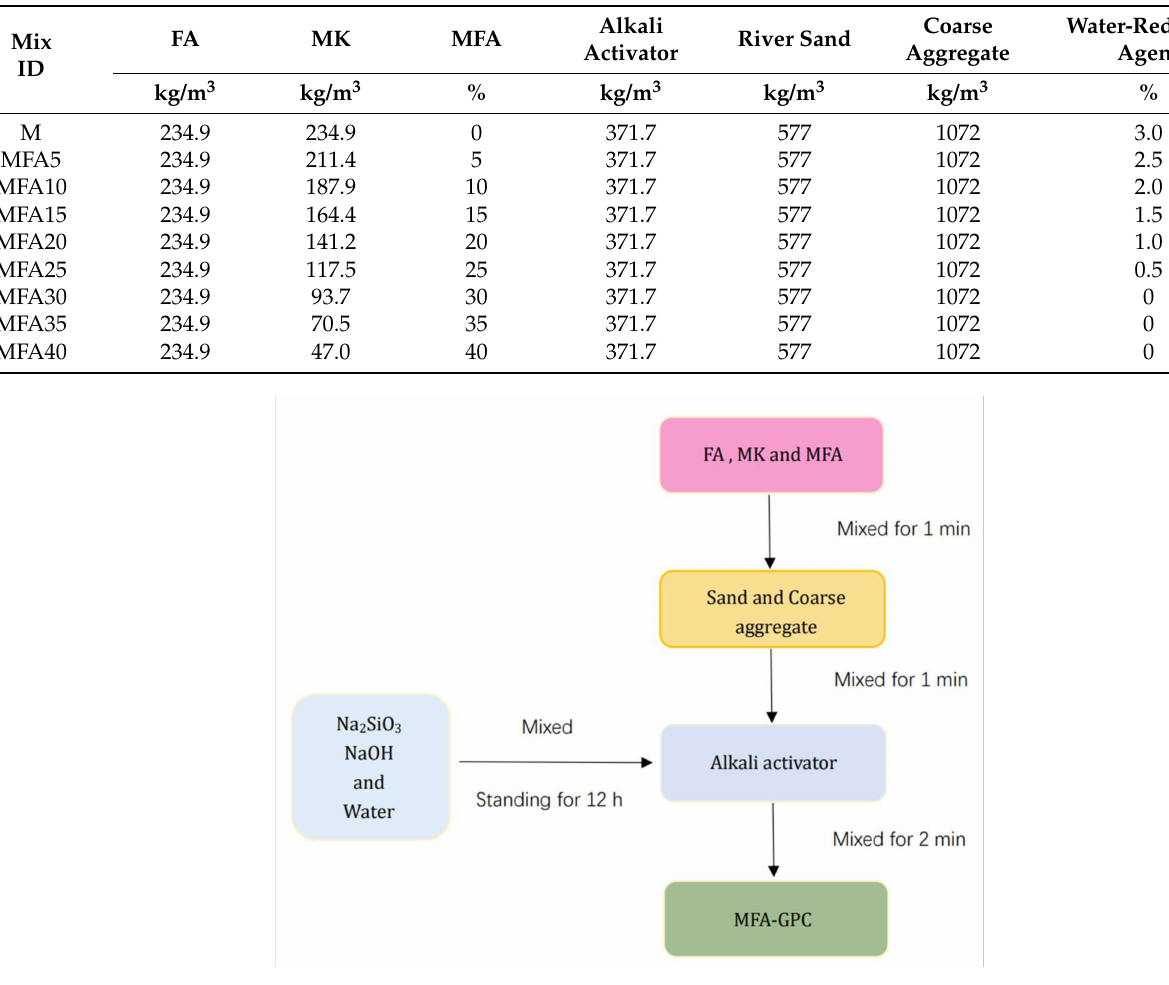
Figure 2. Mixing process of